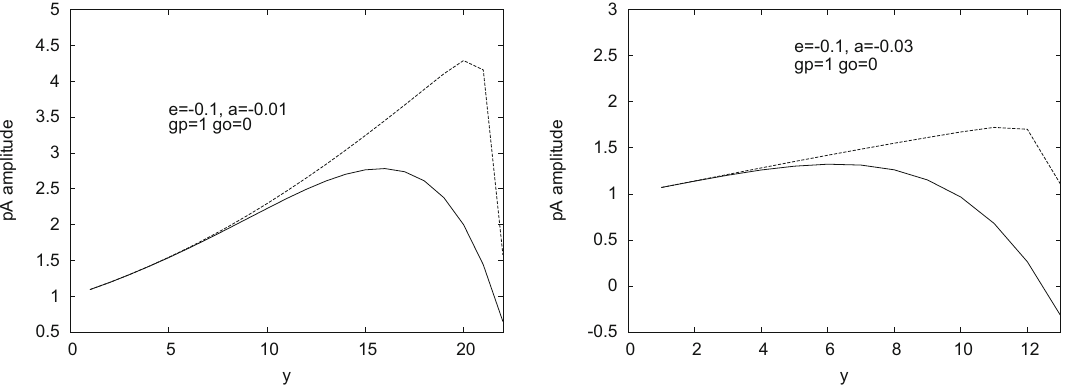
Fig. 4 pA C-even amplitudes at different rapidities for μ p = 0 . 1, λ = 0 . 01 , 0 . 03 and g P = 1 , g O = 0 (lower curves). The upper curves corresponds to summation of the fan diagrams